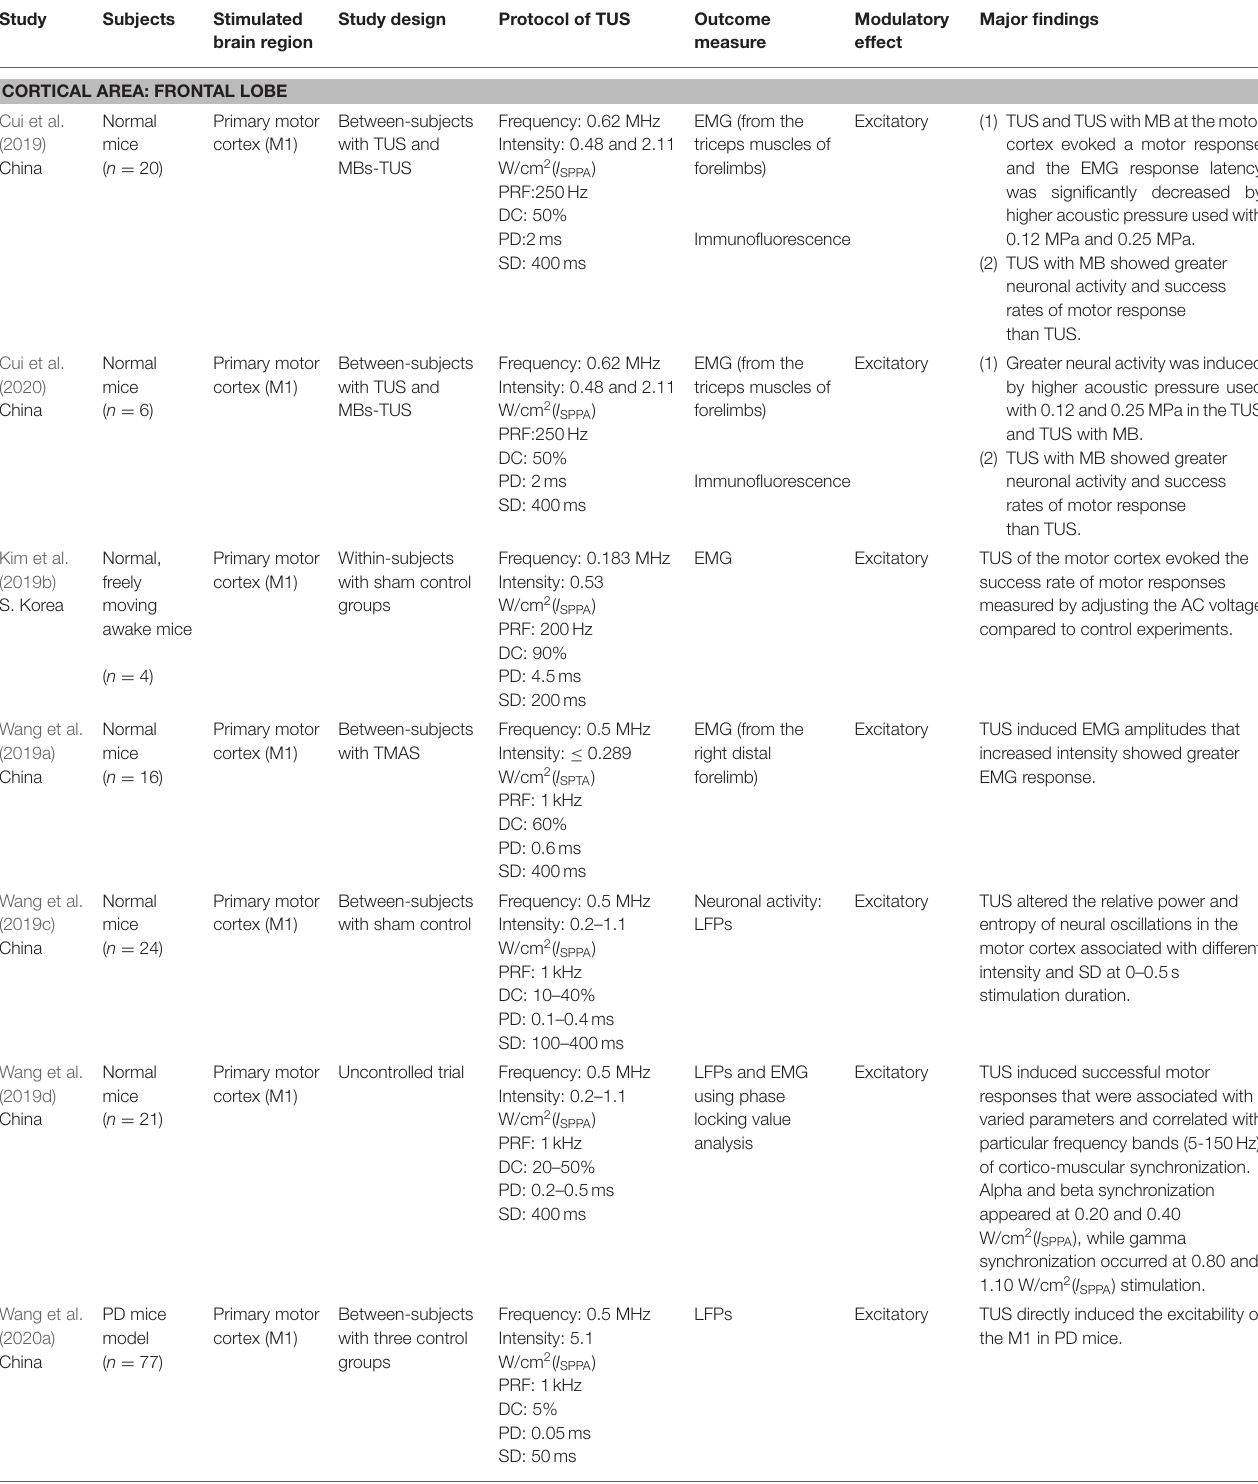
TABLE 1 | Characteristics of studies